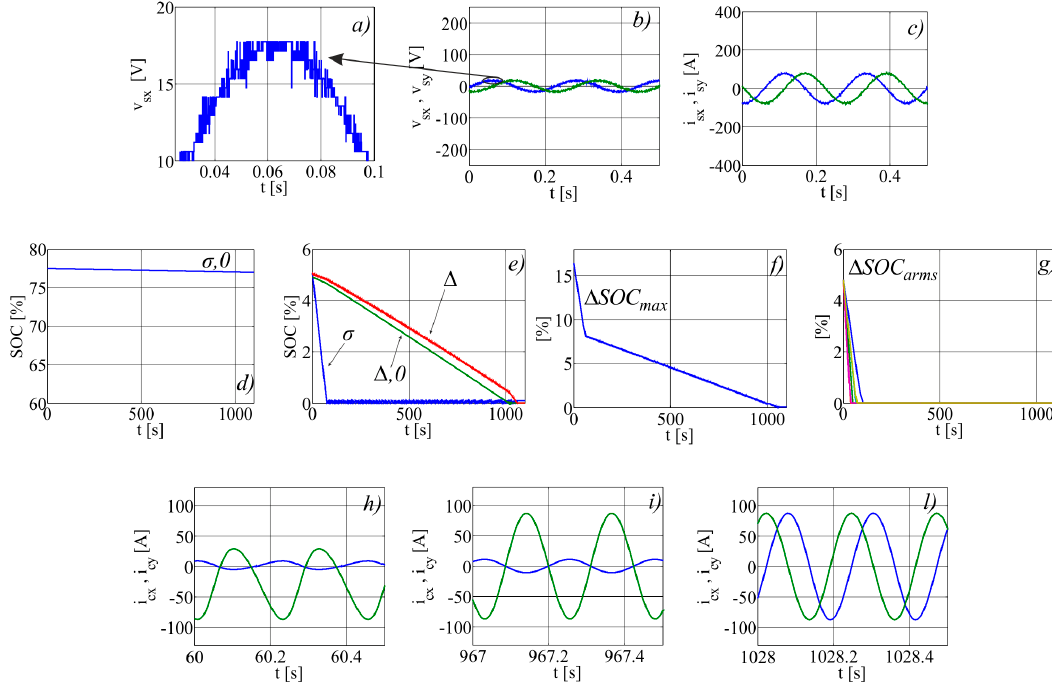
Figure 4. Numerical results for low speed: ( a ) zoom of x motor voltage component; ( b ) x,y motor voltage components; ( c ) x,y motor current components; ( d ) half of the zero-sequence component of the arms sum SOCs; ( e ) unbalance SOC terms; ( f ) difference between the maximum and the minimum SOC of all cells; ( g ) difference between the maximum and the minimum SOC of the six arms; x,y circulating current components when all three hysteresis regulators are ON ( h ), only two regulators are ON ( i ); and, only one regulator is ON ( l ).